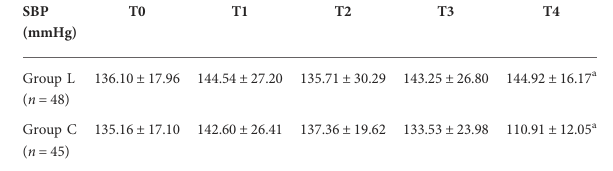
TABLE 3 Systolic blood pressure (SBP) of two groups at different time points ( (cid:1) x + s ) compared with group C; a p <.05. SBP T0 T1 T2 T3 T4 (mmHg)